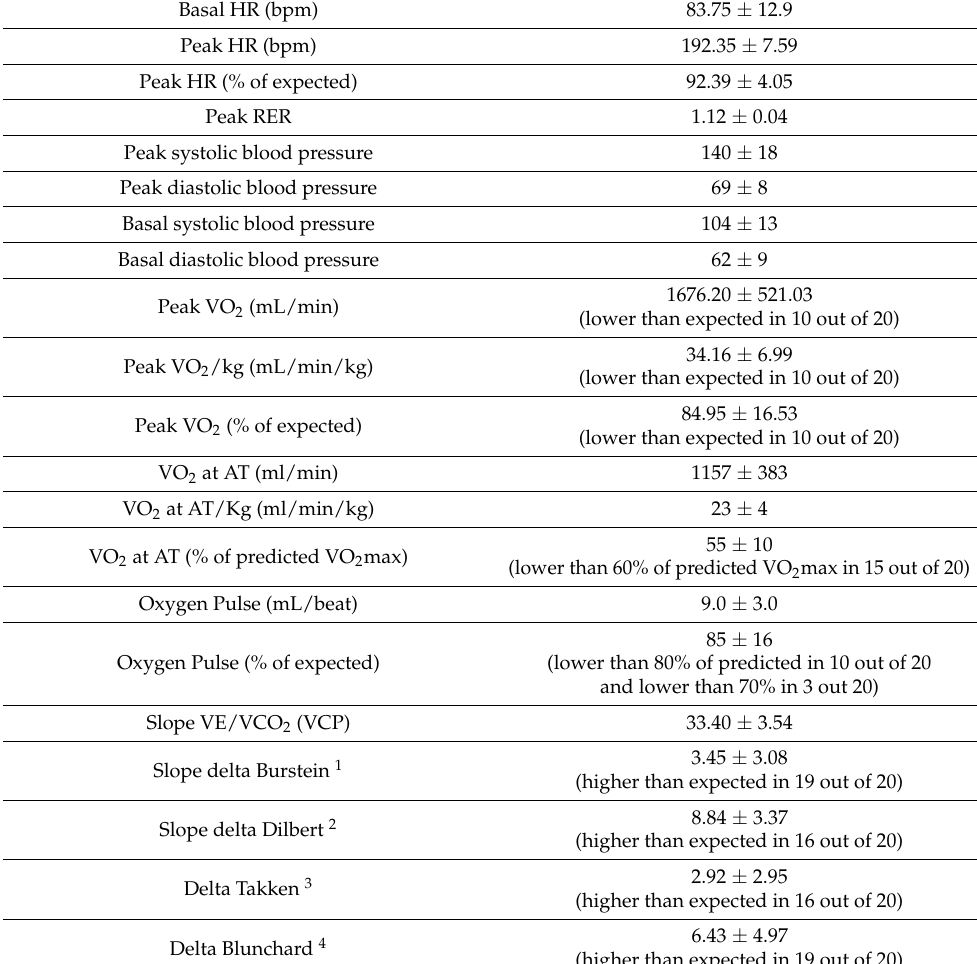
Table 3. Detailed summary of the CPET main